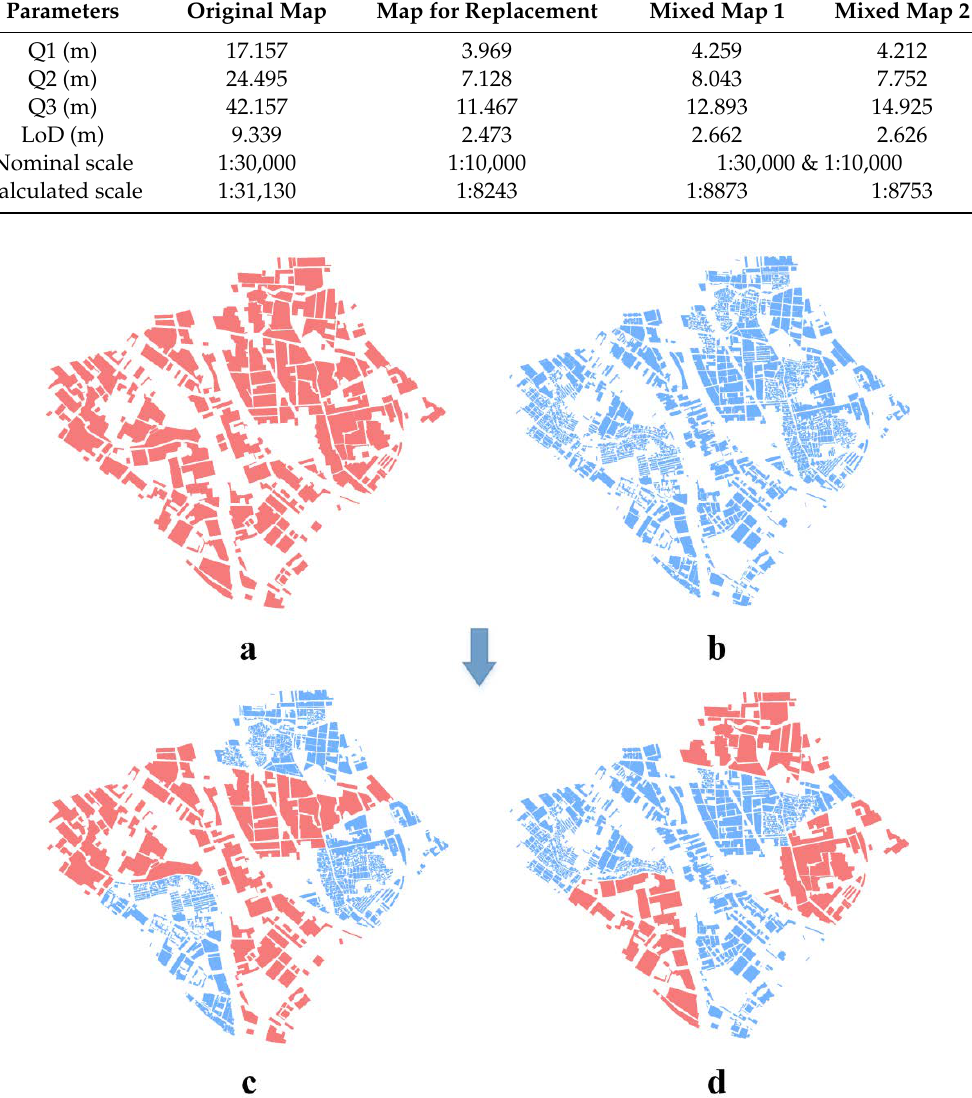
Figure 12. Replacing some large-scale buildings into a small-scale map. ( a ) Original small-scale buildings. ( b ) Large scale buildings for replacement. ( c ) Mixed map 1. ( d ) Mixed map 2. (The red polygons represent the original small-scale geographic buildings with a scale of 1: 30,000, the blue polygons represent “Wrong Data” on a large scale, with a scale of 1: 10,000.)